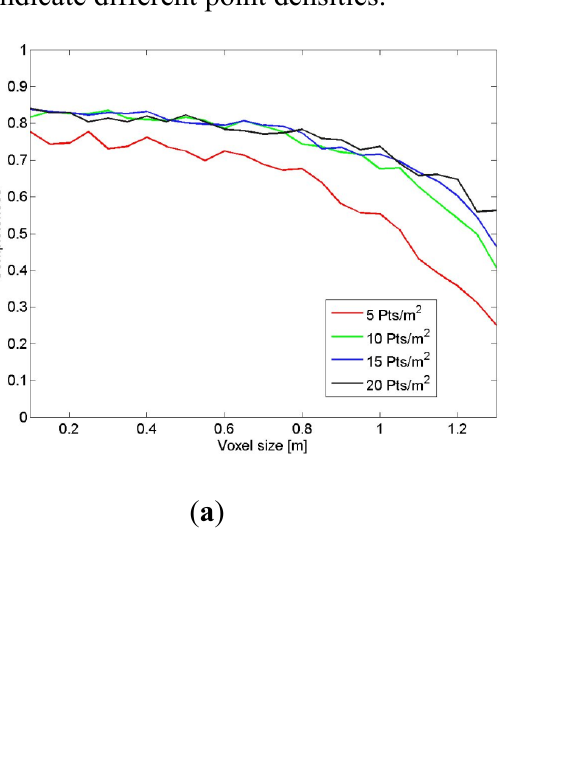
Figure 10. Sensitivity analysis with respect to the parameter II acquired under leaf-off condition; ( a ) Completeness; ( b ) Correctness; colored lines indicate different point